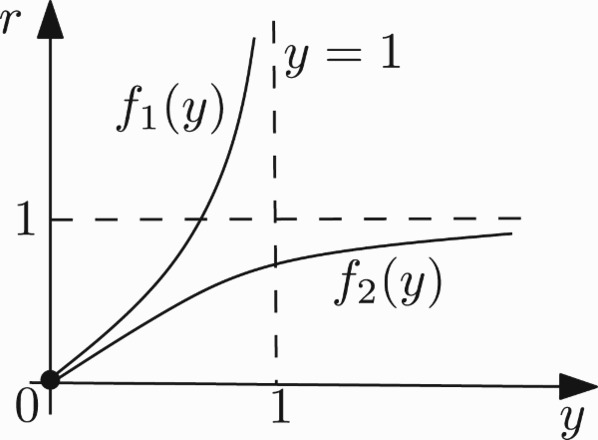
Graph of the functions f
1 and f
2 in the case 0<a≤1/k.